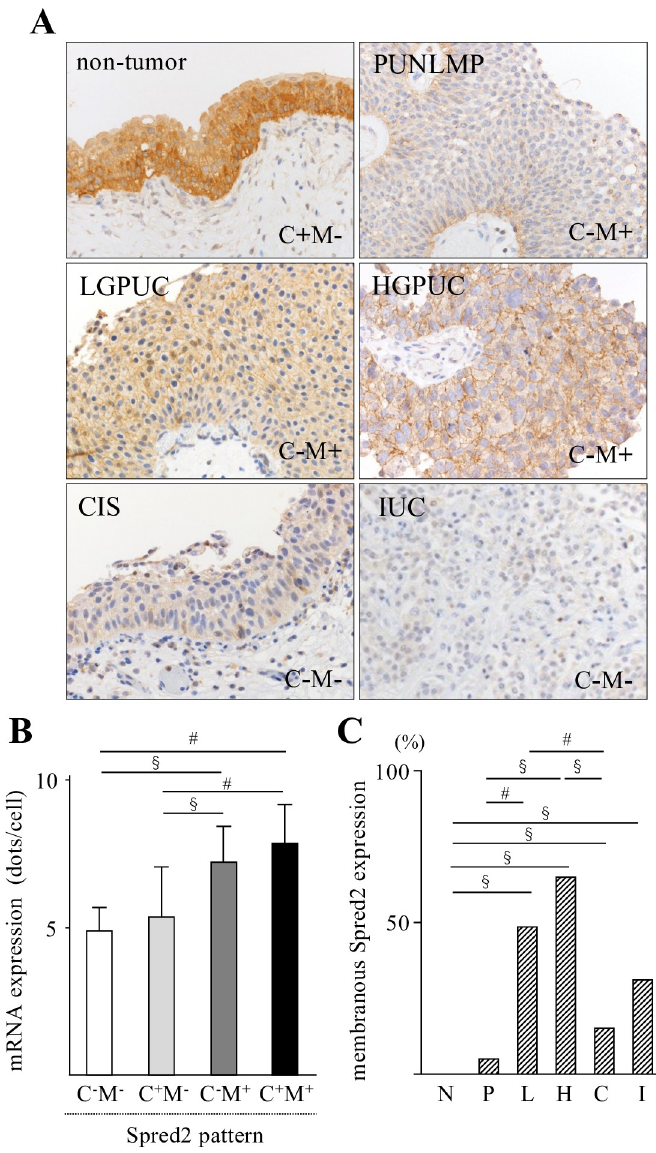
Fig 2. Immunohistochemical analyses of Spred2 protein expression in urothelial tumors. (A) Representative photographs of Spred2 immunohistochemistry (original magnification 400 × ) from each category are shown. (B) Expression levels of Spred2 mRNA in each Spred2 staining pattern were shown. C; cytoplasm, M; membrane. (C-M-; n = 81, C+M-; n = 122, C-M+; n = 54, C+M+; n = 11). Data were mean ± SEM. # p < 0.05, § p < 0.01 (Dunn’s multiple comparison test). (C) The positive rate of membranous Spred2 expression in each category was shown (N: non-tumor; n = 101, P: PUNLMP; n = 19, L: LGPUC; n = 41, H: HGPUC; n = 43, C: CIS; n = 39, and I: IUC; n = 32). Data were mean ± SEM. # p < 0.05, § p < 0.01 (Multiple Fisher’s exact